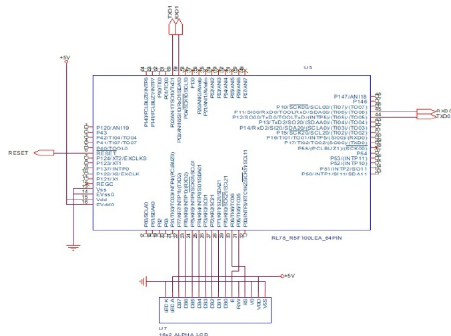
Figure 8. Circuit Diagram of LCD with 64 Pin